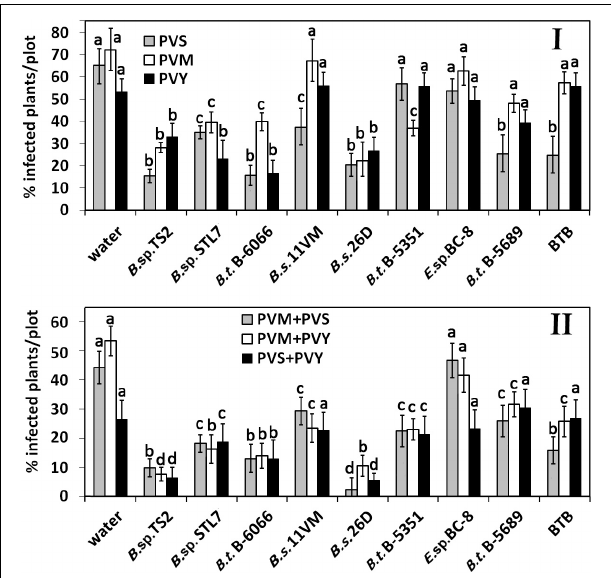
FIGURE 3 | Effect of bacterial agents and Bitoksibacilline (BTB) treatments of potato plants on the prevalence of potato virus Y (PVY), potato virus M (PVM), and potato virus S (PVS) in potato plots on the 31st day (2019) and 29th day (2020) after treatment: percentage of samples that tested positively for each virus (I) and samples that tested positive for two viruses simultaneously (II) . Data represented as mean values ± standard error; values followed by the same alphabet within a column are not significantly different from each other according to Tukey’s honestly significant difference (HSD) multiple-range test at P < 0.05.